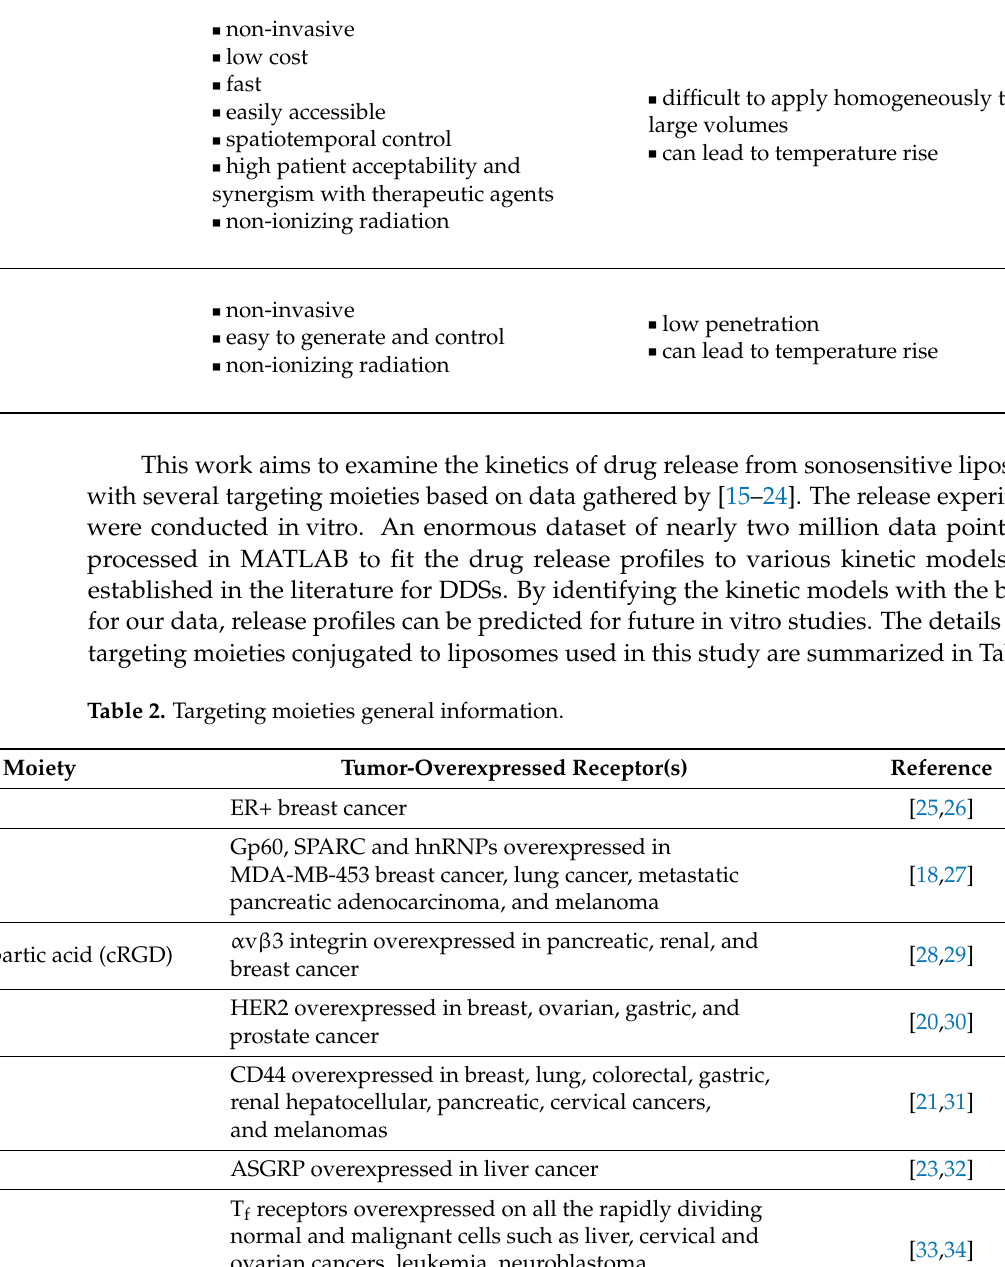
Table 1. Cont. Table 1. The advantages and disadvantages of drug delivery trigger mechanisms. Table 1. The advantages and disadvantages of drug delivery trigger mechanisms. Table 1. The advantages and disadvantages of drug delivery trigger mechanisms. Table 1. The advantages and disadvantages of drug delivery trigger mechanisms. Table 1. The advantages and disadvantages of drug delivery trigger mechanisms. Table 1. The advantages and disadvantages of drug delivery trigger mechanisms. Table 1. The advantages and disadvantages of drug delivery trigger mechanisms. Table 1. The advantages and disadvantages of drug delivery trigger mechanisms. Table 1. The advantages and disadvantages of drug delivery trigger mechanisms.